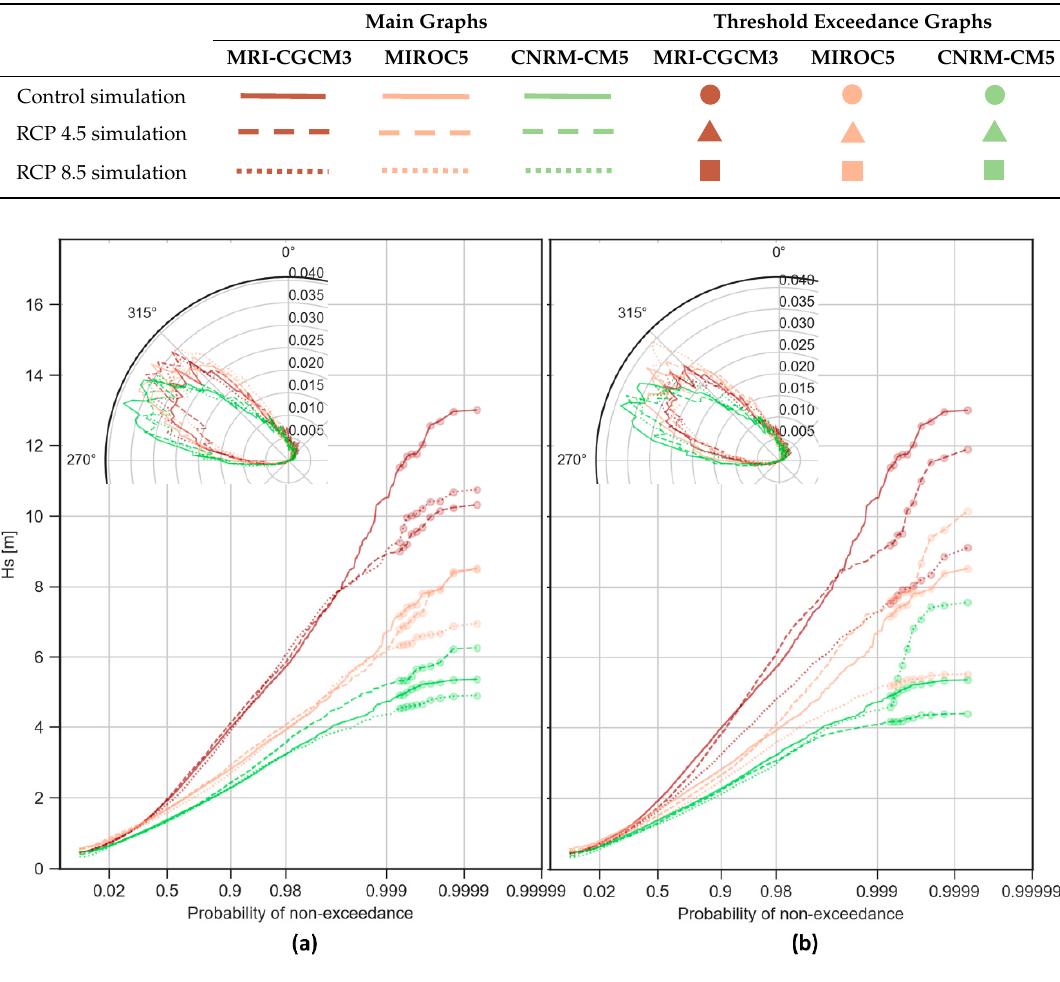
Table 1. Unified legend for all the graphs in Appendix A. The color code represents each of the three GCMs studied. Normal lines are used for control scenarios, dashed lines for RCP4.5 scenarios and dotted lines for RCP8.5 scenarios. In the threshold analysis, circles are used for control scenarios, triangles for RCP4.5 scenarios and squares for RCP8.5 scenarios.